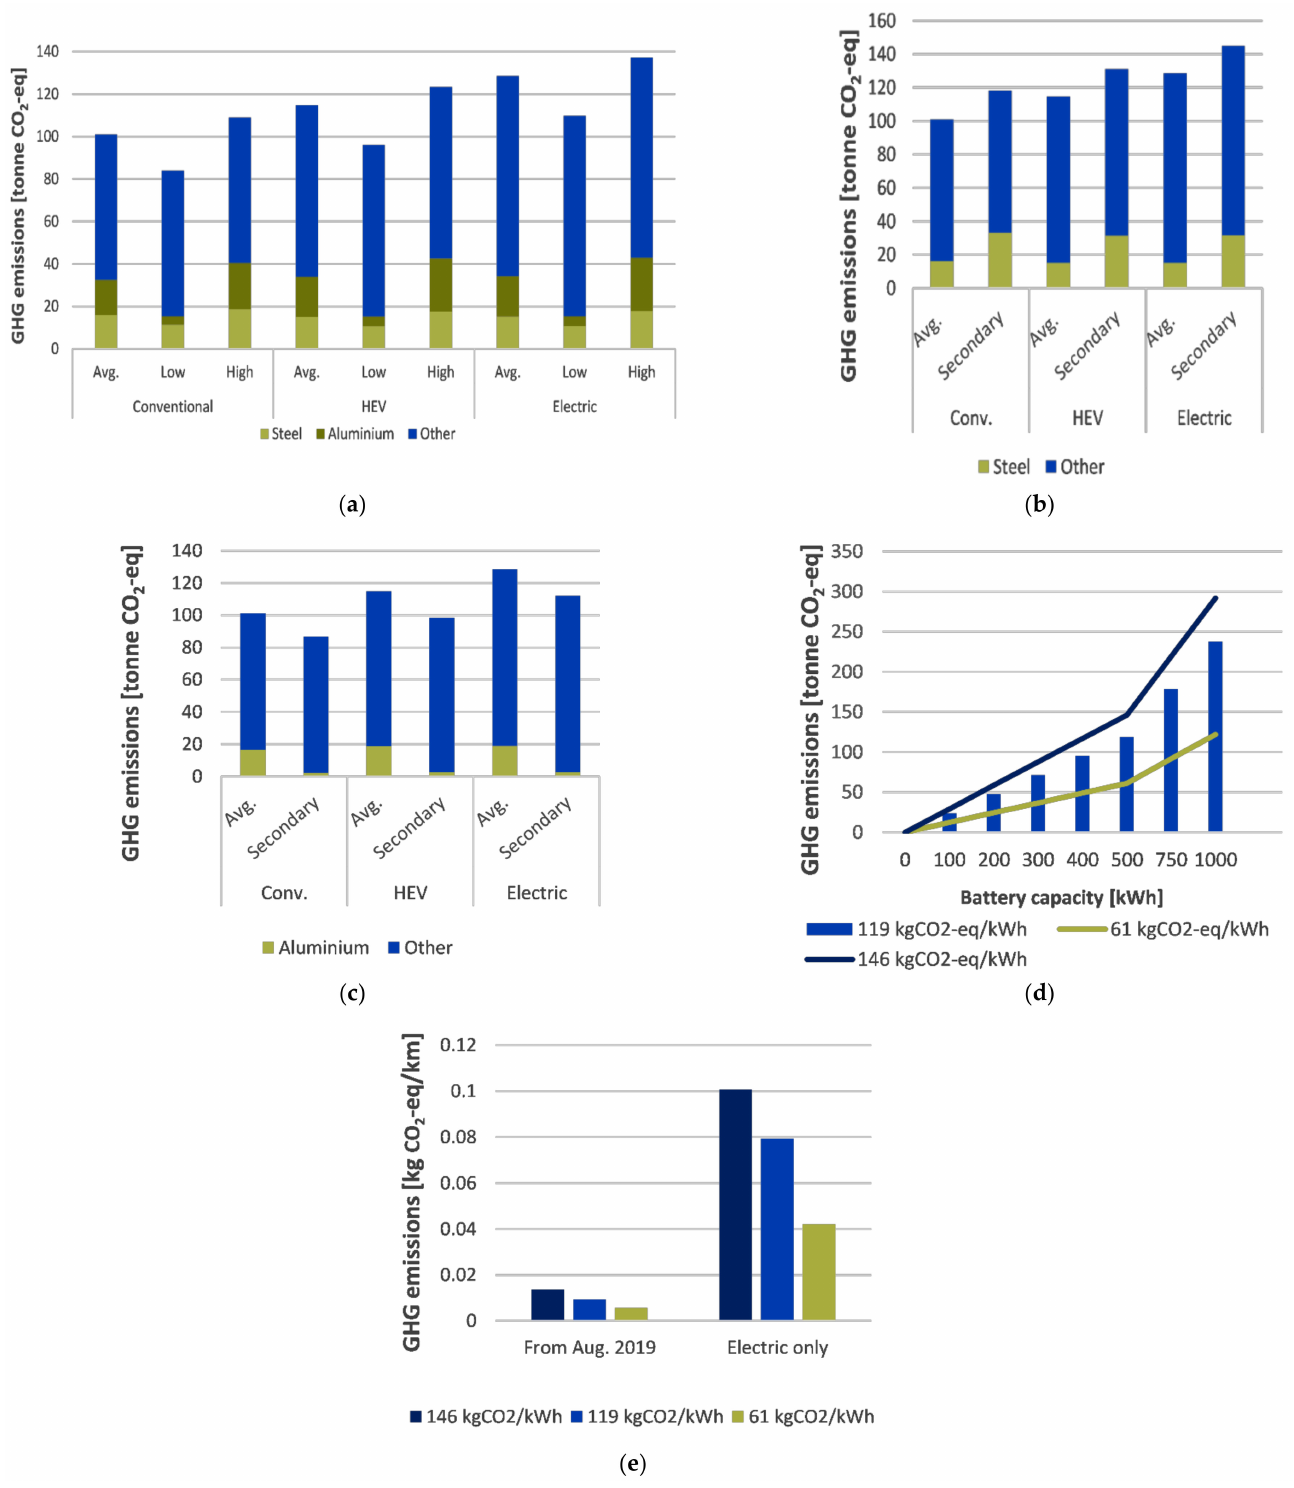
Figure 6. ( a ), sensitivity analysis on primary steel and aluminium production emissions; ( b ), sensitivity analysis on secondary steel production emissions; ( c ), sensitivity analysis on secondary aluminium production emissions; ( d ), sensitivity analysis on battery capacity and carbon intensity for production emissions; and, ( e ), sensitivity analysis on bus fleet battery production emissions. Avg. represents the average material emissions in production. Low and high depicts low and high emissions in material production. Secondary depicts emissions that accumulate from producing material in a secondary